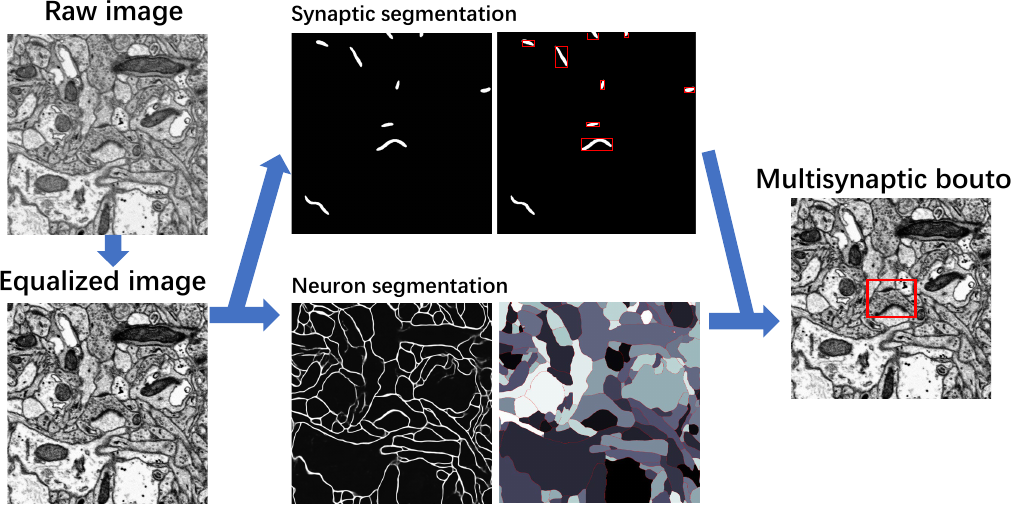
Figure 3. The workflow of our method for MSB detection from a serial EM image